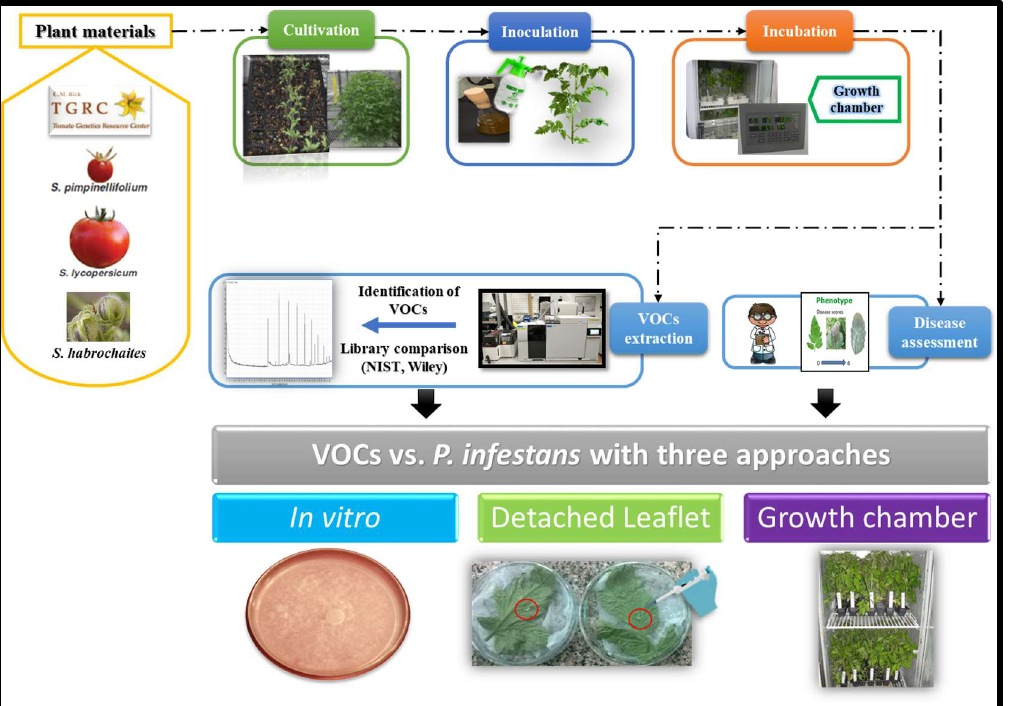
Figure 8. Workflow of volatile organic compounds emission in tomato wild relatives and their extraction using gas chromatography-mass spectrometry as well as their impact on tomato late blight caused by P. infestans .